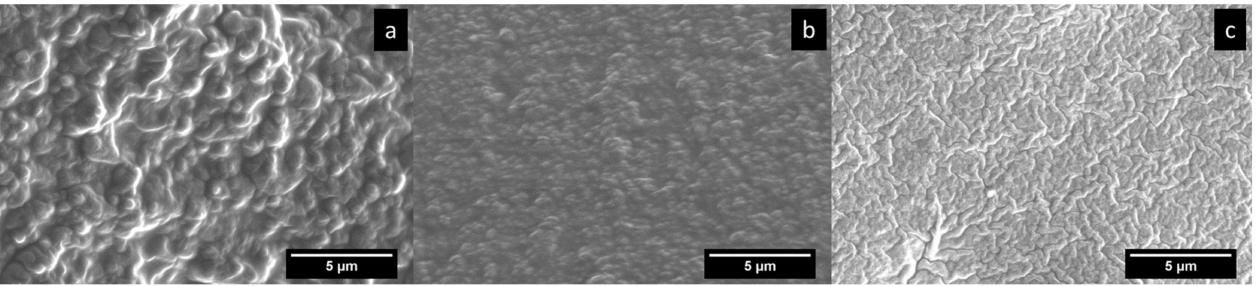
Figure 3. Cross-section morphology of samples A1C1 ( a ), A2C1 ( b ), and A1C2 ( c ); 5 µ m scale.